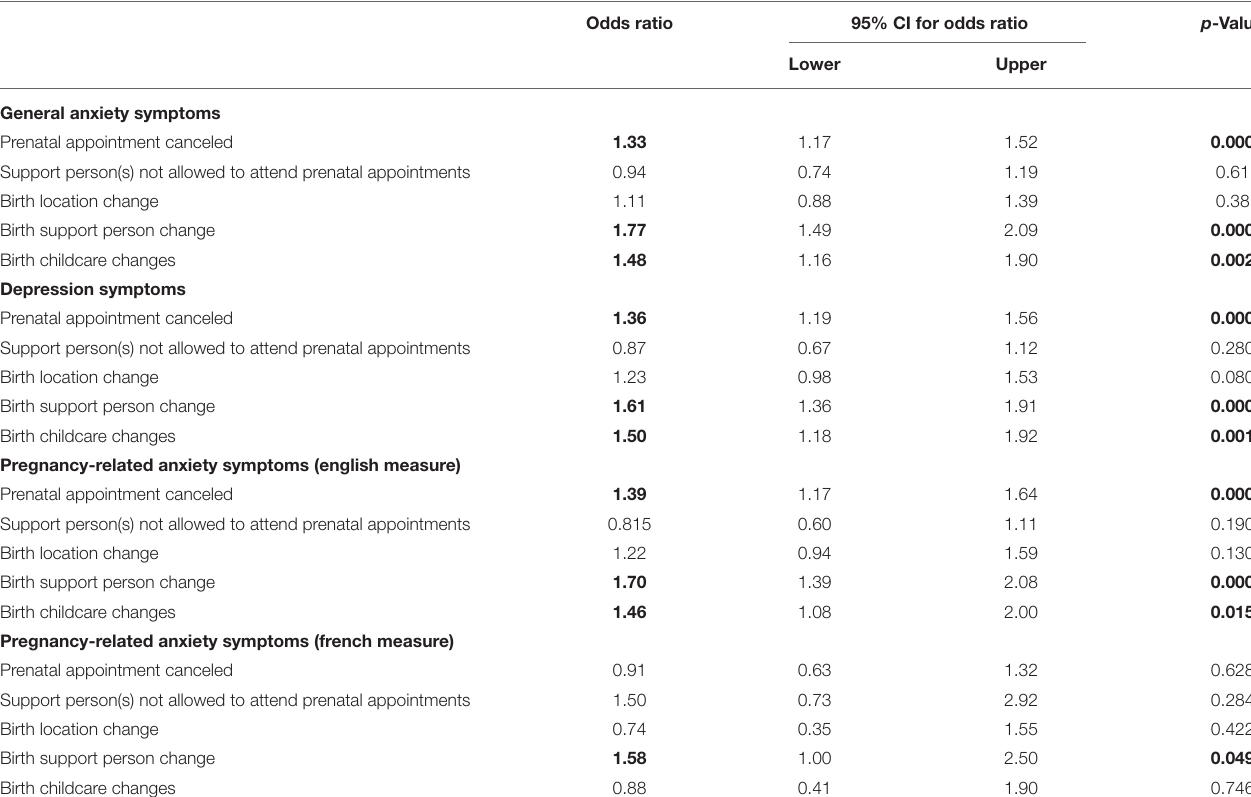
TABLE 2 | Prenatal care disruptions and symptoms of maternal distress a .